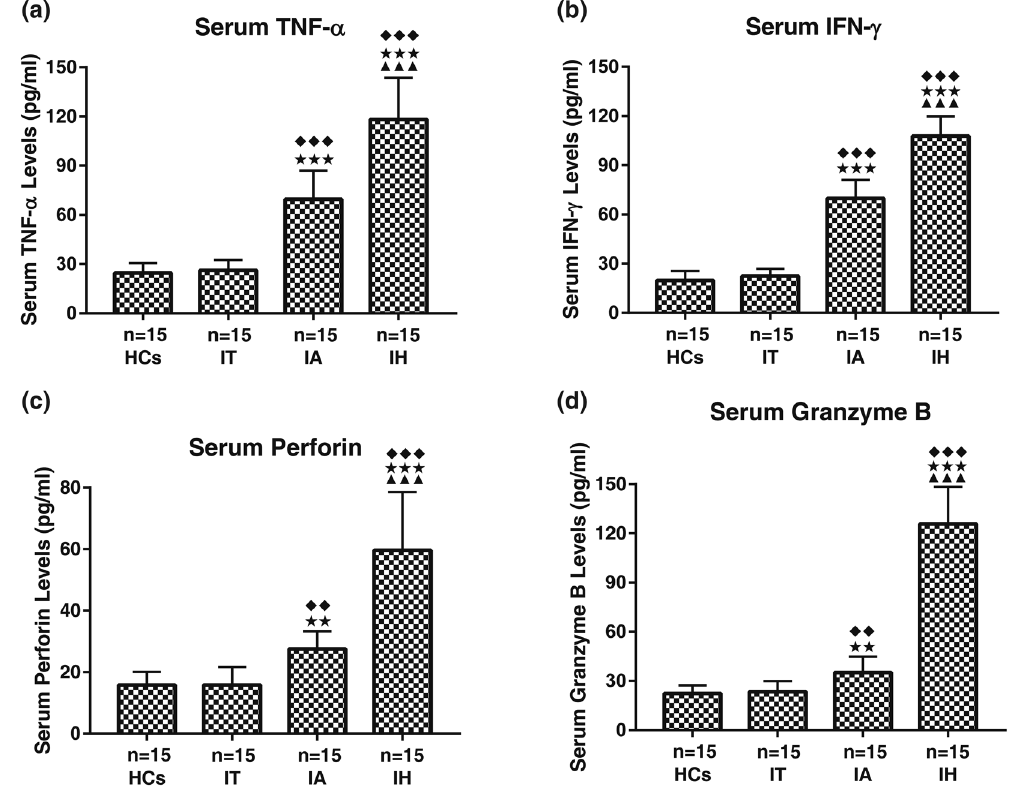
Figure 5. Serum Levels of IFN- γ , TNF- α , perforin and granzyme B in different clinical stages of chronic HBV- infected patients. HCs, healthy controls; IT, chronic HBV carriers; IA, CHB patients; IH, HBV-ACLF. Nemenyi test following Kruskal-Wallis H test were used for comparing IFN- γ , TNF- α , perforin and granzyme B levels between two compared groups. Compared with HCs group, ◆◆◆ P < 0.01, ◆◆ P < 0.05; Compared with IT group, ★★★ P < 0.01, ★★ P < 0.05; Compared with IA group, ▲▲▲ P <